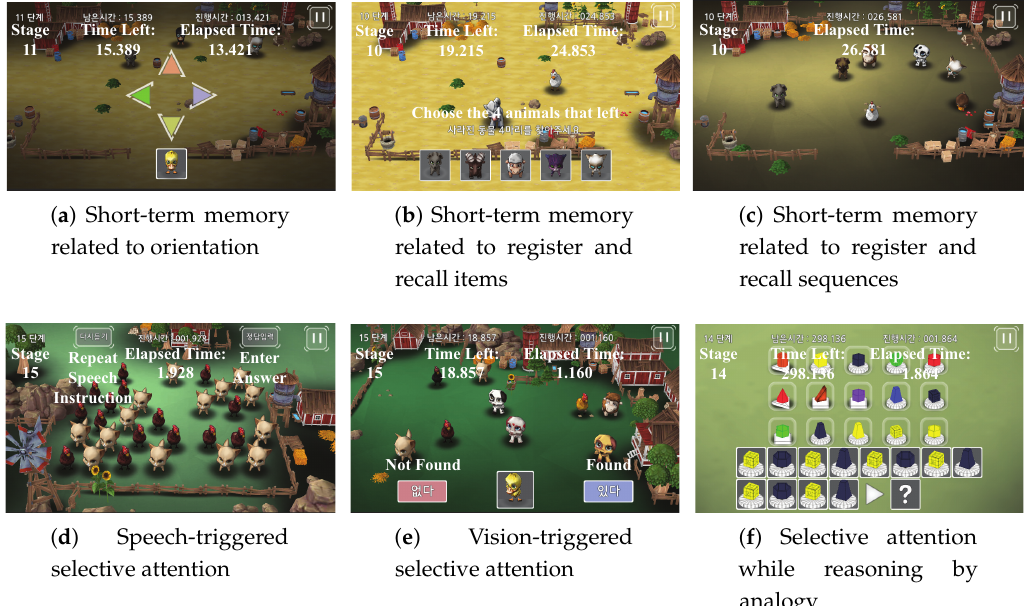
Figure 1. The screenshots of the six games of Neuro-World . All the games were administered in Korean, and English translations were added post clinical study for readers. A detailed explanation for each game is provided in Appendix